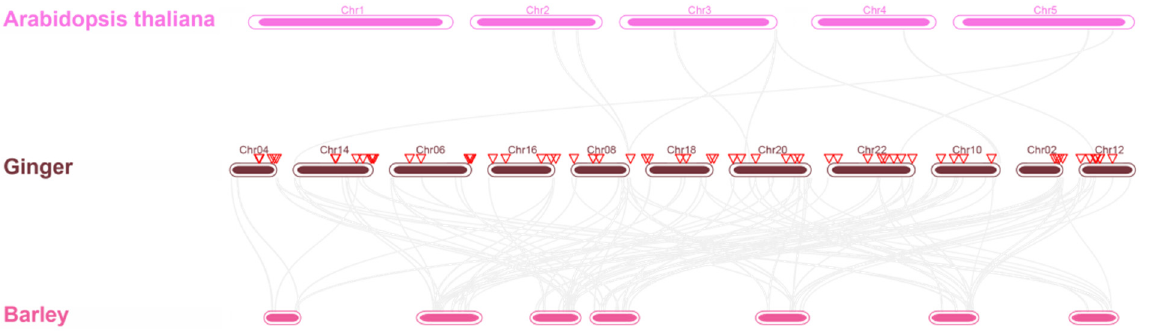
Figure 8. Collinearity analysis of ginger, Arabidopsis, and Barley. The red inverted triangles repre- sents the ZoGRAS genes.